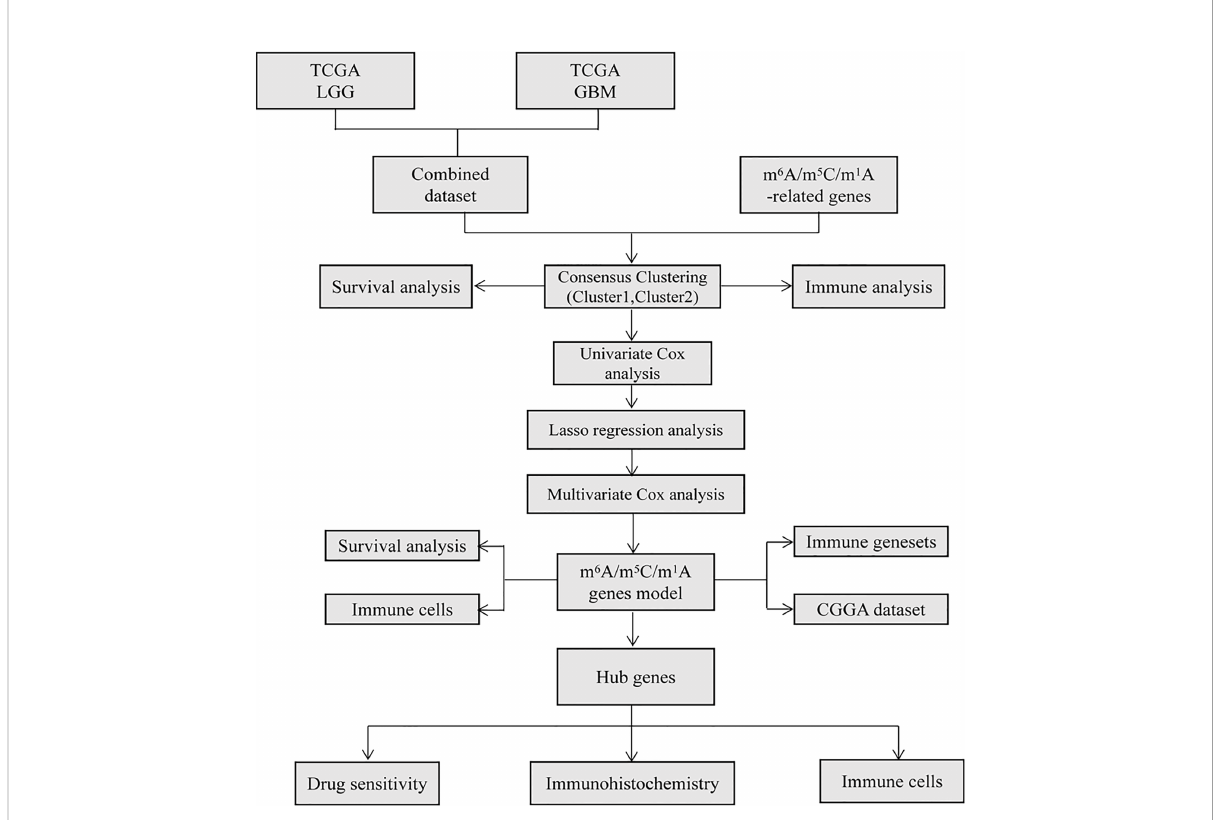
FIGURE 1 Flow chart in the current study. TCGA database was used to extract and integrate glioma data, and the differences of m 6 A/m 5 C/m 1 A related genes were analyzed. Based on these differentially expressed genes, different glioma clusters were obtained by consistent cluster analysis, and the survival and immunity of different clusters were analyzed. The prognostic model was constructed by Cox and Lasso regression, the risk score was calculated, the survival and immunity between high and low risk groups were compared, and the accuracy of the model was veri fi ed by CGGA database. Finally, the correlation between hub genes and immune cells and the sensitivity of drugs were analyzed and veri fi ed by